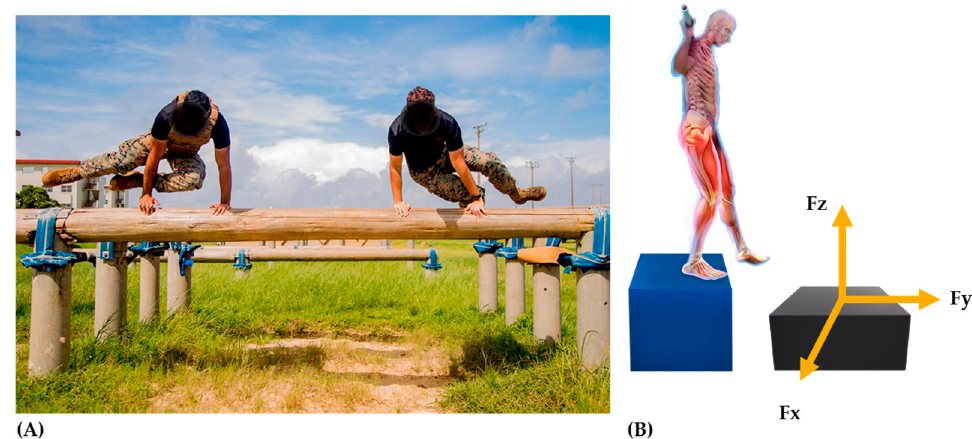
Figure 1. Practical training scenario of soldiers jumping over and landing from obstacles in loaded (weighted vest) and unloaded conditions ( A ). The use of drop jump testing onto force plates; ( B ) to understand the amount of forces (Fz, vertical ground reaction forces, vGRFs; Fy, saggital plane; Fx, frontal plane) occurring during landing tasks. The appearance of U.S. Department of Defense (DoD) visual information does not imply or constitute DoD endorsement.